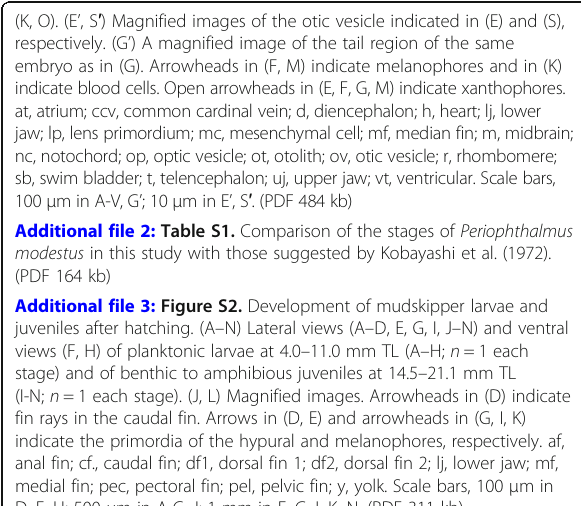
Additional file 2: Table S1. Comparison of the stages of Periophthalmus modestus in this study with those suggested by Kobayashi et al. (1972). (PDF 164 kb) Additional file 3: Figure S2. Development of mudskipper larvae and juveniles after hatching. (A – N) Lateral views (A – D, E, G, I, J – N) and ventral views (F, H) of planktonic larvae at 4.0 – 11.0 mm TL (A – H; n = 1 each stage) and of benthic to amphibious juveniles at 14.5 – 21.1 mm TL (I-N; n = 1 each stage). (J, L) Magnified images. Arrowheads in (D) indicate fin rays in the caudal fin. Arrows in (D, E) and arrowheads in (G, I, K) indicate the primordia of the hypural and melanophores, respectively. af, anal fin; cf., caudal fin; df1, dorsal fin 1; df2, dorsal fin 2; lj, lower jaw; mf, medial fin; pec, pectoral fin; pel, pelvic fin; y, yolk. Scale bars, 100 μ m in D, F, H; 500 μ m in A-C, J; 1 mm in E, G, I, K – N. (PDF 311